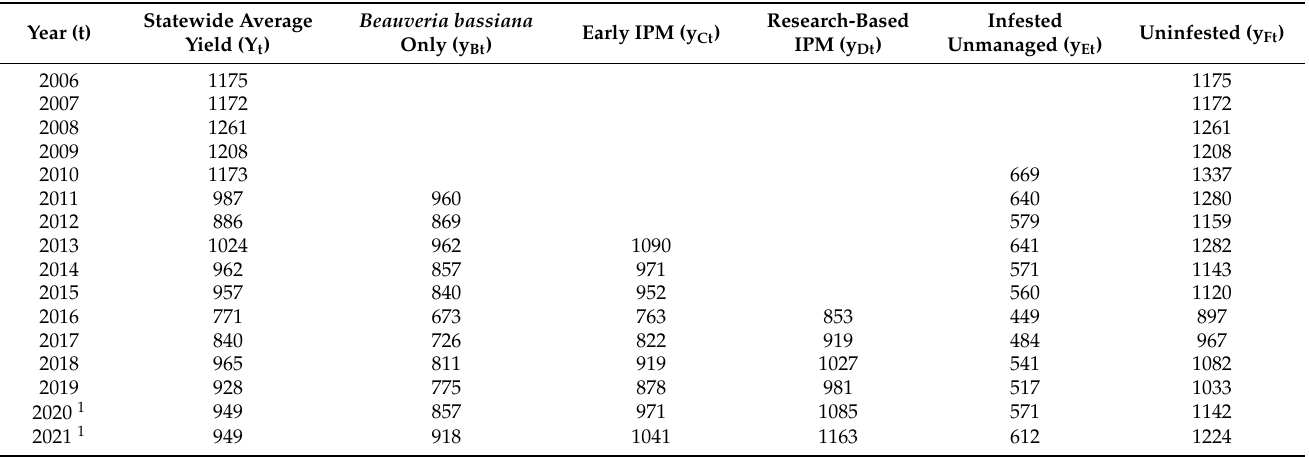
Table 1. Observed statewide average coffee yield (parchment pounds per acre) from 2006 to 2021, and statewide yield based on various management